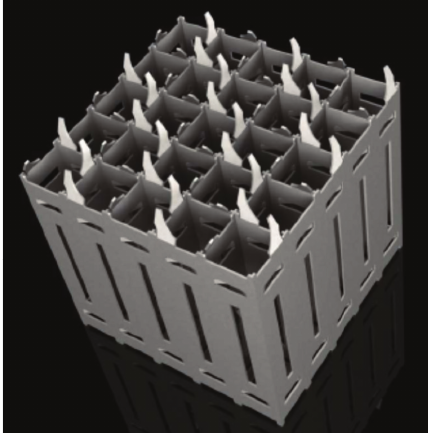
Figure 6: Radial power distribution B.